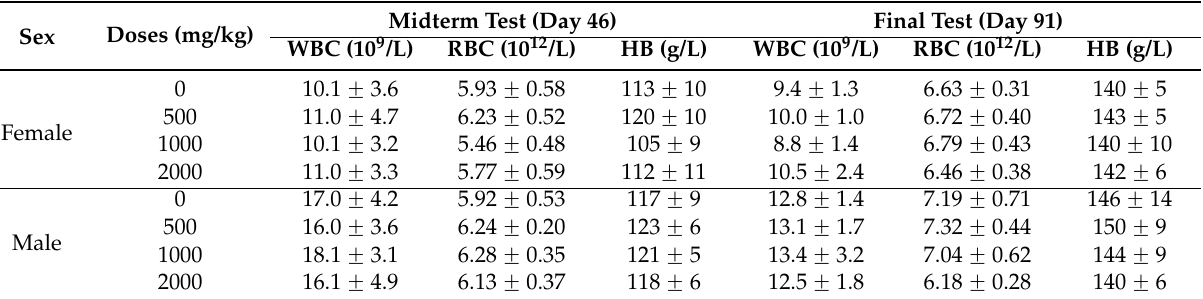
Table 6. Effect of GBP on hematological cell counts (CBC) (x ˘ s, n = 10).